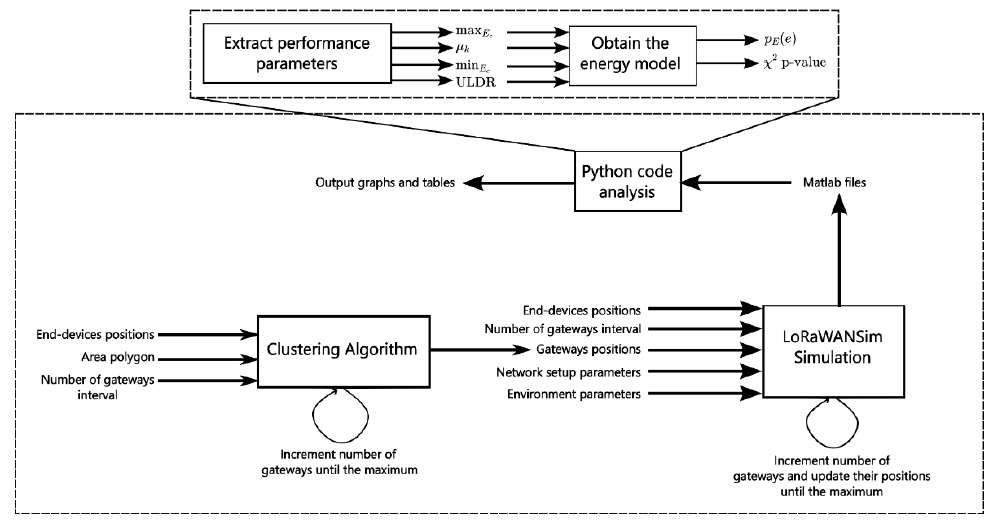
Figure 6. Diagram of the proposed method to improve and analyze the WSN